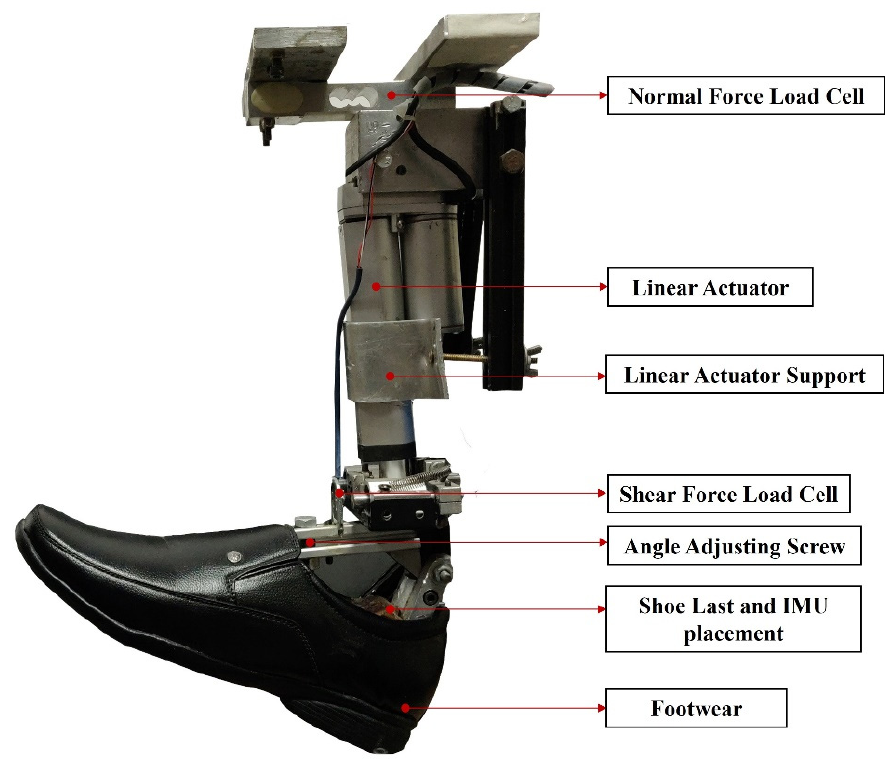
Figure 3. Vertical motion and angle adjustment assembly.